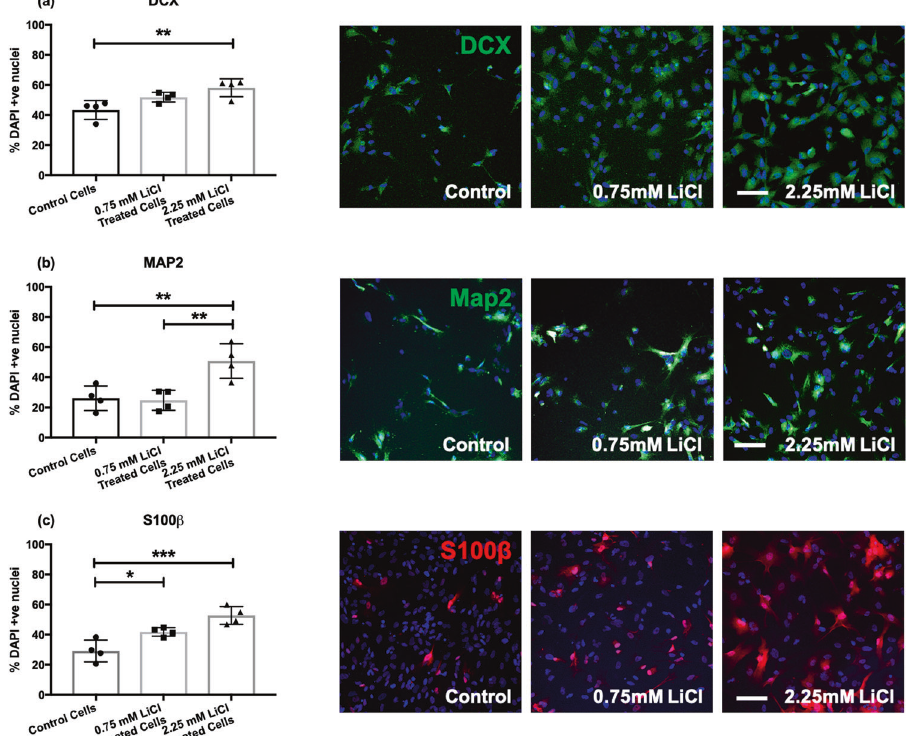
Fig. 3 Bar charts showing the percentage of DCX, MAP2, and S100 β positive cells in those treated chronically with a vehicle control (0 mM), low (0.75 mM), or high (2.25 mM) dose of lithium chloride. The bar charts (left) show the percentage of DCX ( a ), MAP2 ( b ), and S100 β ( c ) positive cells relative to the percentage of DAPI stained nuclei in control and lithium-treated cells. Each data point represents one biological replicate ( N = 4). * represents P ≤ 0.05, ** represents P ≤ 0.01, and *** represents P ≤ 0.001, based on the result of Tukey ’ s post hoc tests. Each of the images (right) are representative of a fi eld of immuno-stained cells, taken using a 10X objective with the CellInsight High Content Screening Platform. Each image includes the nuclear marker DAPI in blue. Scale bar = 100 μ m.